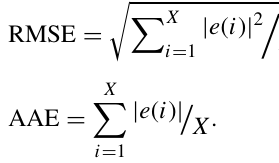
Fig. 6 Parameter v 3 estimation curve